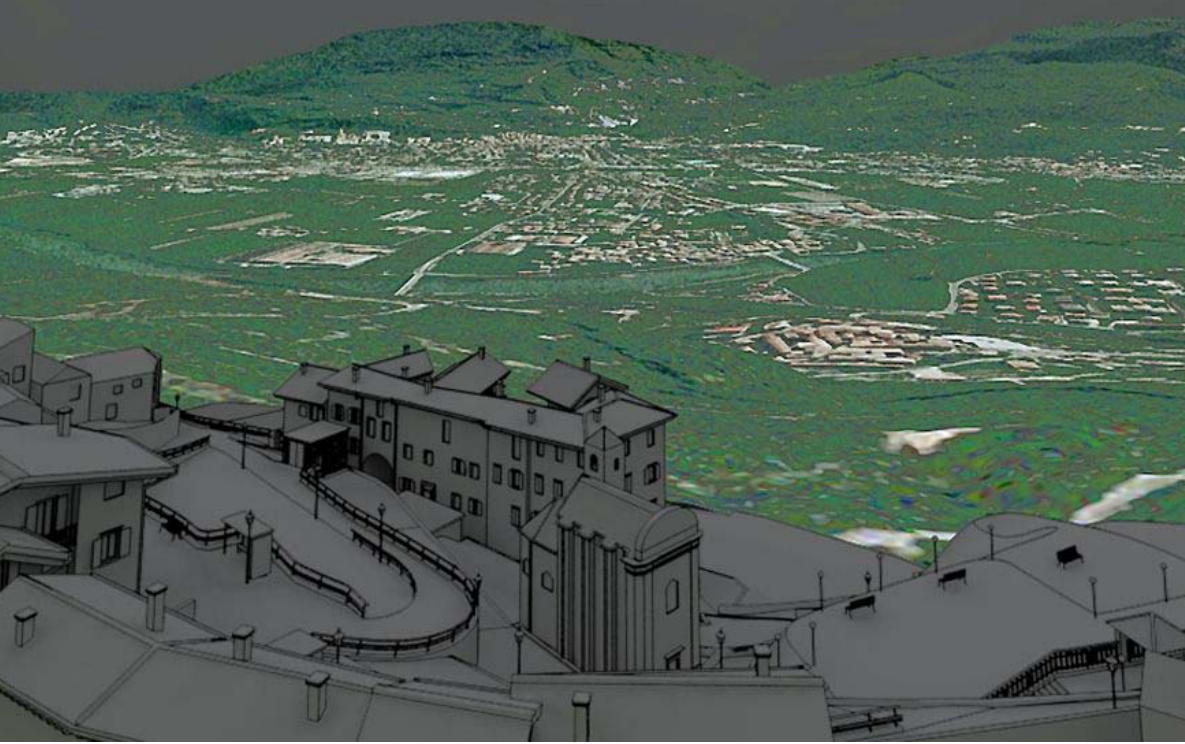
Figure 7. Folaso, hamlet of Isera (TN): 3D urban model visualization related to its territorial context (authors: Francesca Angileri, Jole Avi, Marta Cocco, Claudia